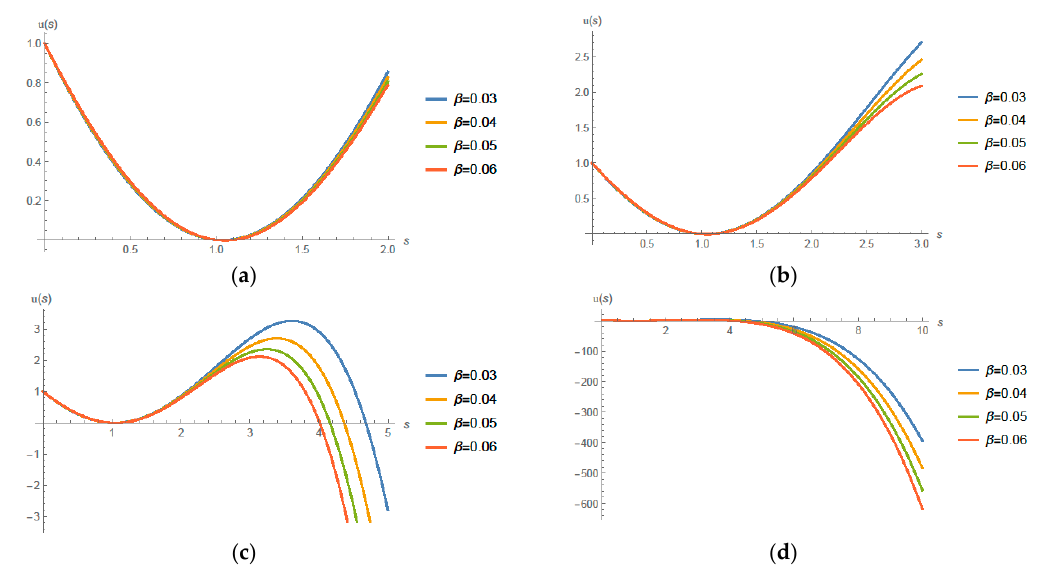
Figure 3. 𝑢(𝑠) at different values of β and varying ranges of 𝑠 . ( a ) with the s range of [0–2]; ( b ) with Figure 3. u ( s ) at di ff erent values of β and varying ranges of s . ( a ) with the s range of [0–2]; ( b ) with the s range of [0–3]; ( c ) with the s range of [0–5]; ( d ) with the s range of [0–10].